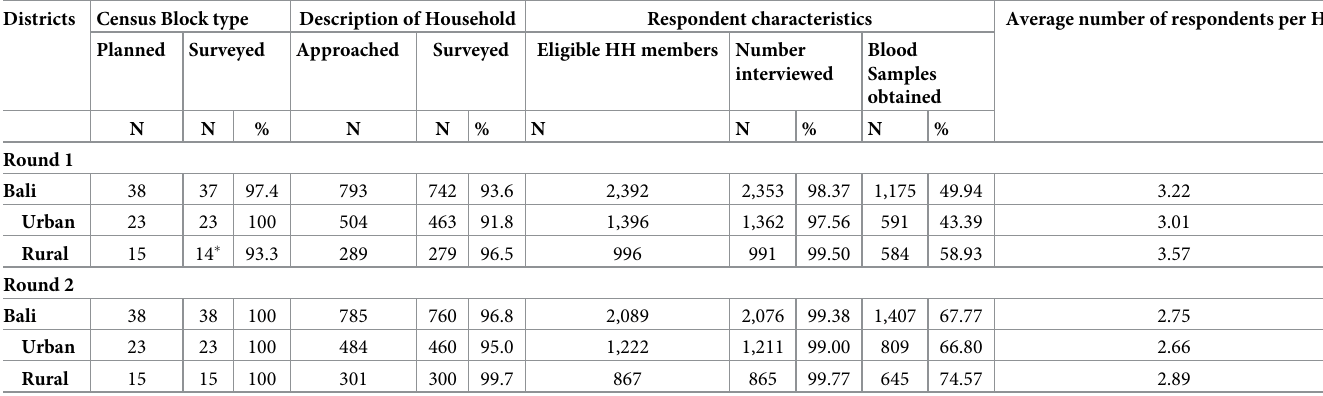
Table 1. Characteristics of survey census